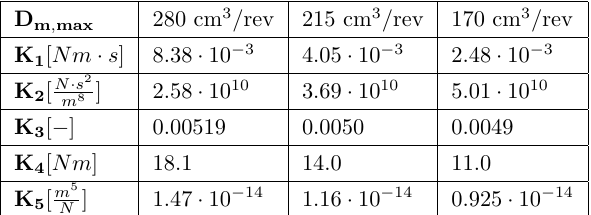
Table 1: Friction model parameters for Bosch Rexroth